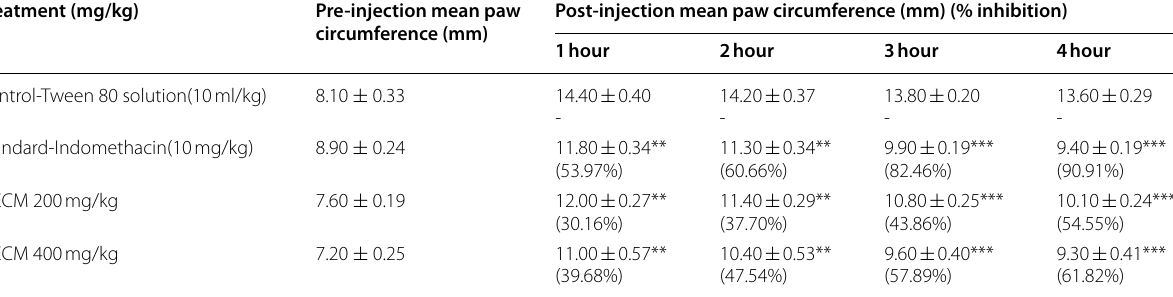
MECM Methanolic extract of seeds, SEM Standard error of the mean All values are expressed as Mean ** p < 0.01, *** p < 0.001 were considered statistically significant compared to control